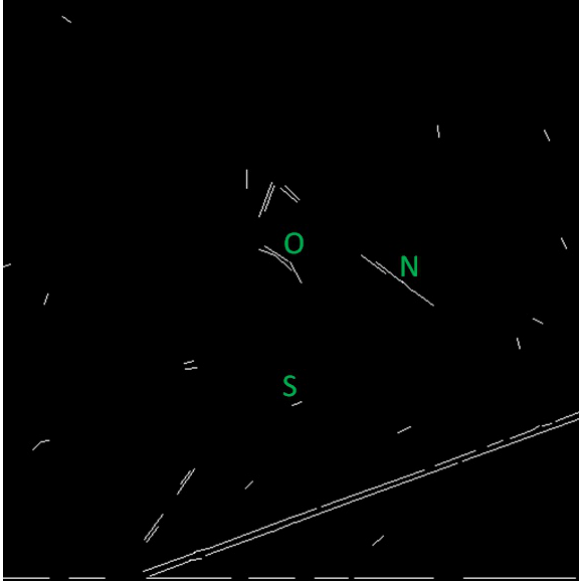
Figure 5. Lines detected by LSD on the merged image is expresses here. In this mask, three different lines are detected. The object path is shown by O, one noise line which exists in a single image is shown by N, and one line which is created by a large star border is shown by S.